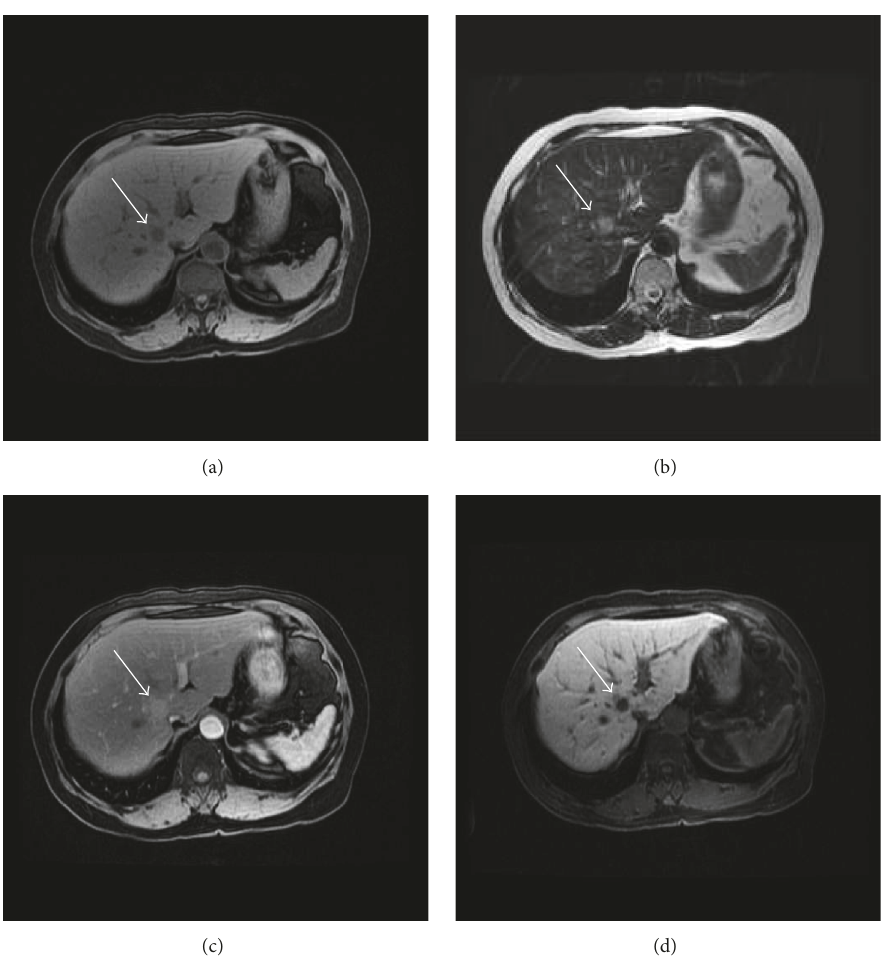
Figure 2: Magnetic resonance imaging. T1-weighted fat suppressed imaging showed low intensity at the tumor of S7 (arrow) (a). T2-weighted imaging showed high intensity at the tumor (b). In Gd-EOB-DTPA enhanced MRI, the tumor was enhanced in the arterial phase (c), and there was low signal intensity in the hepatobiliary phase (d).